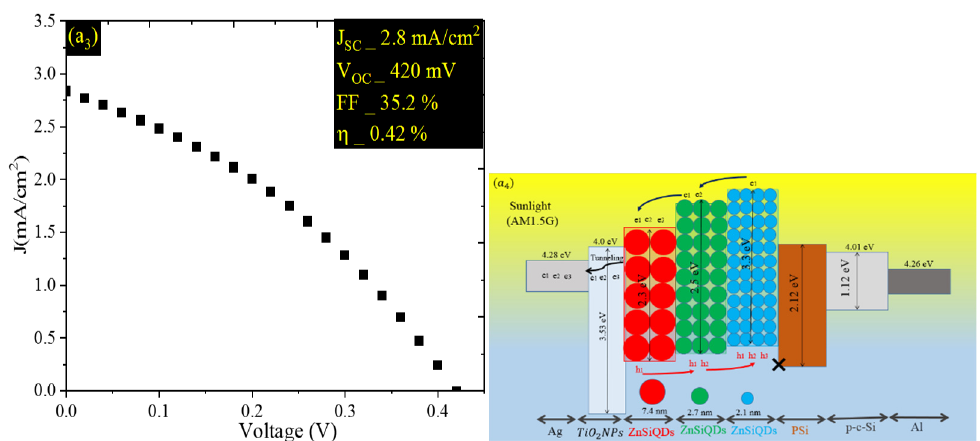
Figure 9. ( a 1 ) Energy band diagram with the hole tunnelling mechanism and electron injection be- tween Valence and conduction states of the solar cell like Al/p-c-Si/PSi/ZnSiQDs (2.3 eV)/ZnSiQDs (2.5 eV)/ZnSiQDs (3.3 eV)/TiO 2 NPs/Ag. ( a 2 ) band diagram showing the mechanism of inserted Zn +2 into SiQDs and electrons injection between the energy levels of the solar cell with TL-ZnSiQDs. ( a 3 ) I-V characteristics and ( a 4 ) Energy band diagram showing the mechanism of electrons injection between the energy levels of the solar cell with the structure of Al/p-c-Si/PSi/ZnSiQDs (3.3 eV)/ZnSiQDs (2.5 eV)/ZnSiQDs (2.3 eV)/TiO 2 NPs/Ag.